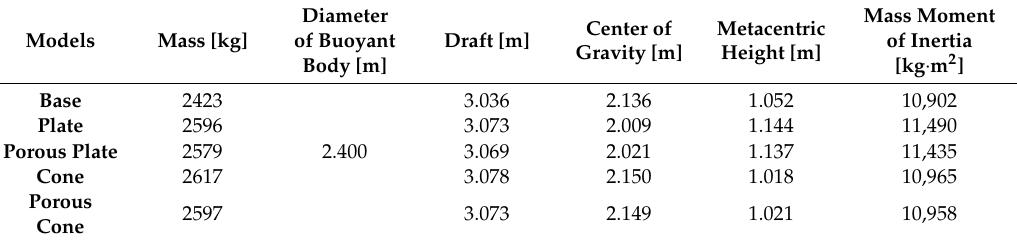
Figure 6. Geometries of lightweight light buoy with and without developed appendages. Table 1. Main particulars and hydrostatic properties of the lightweight light buoys.